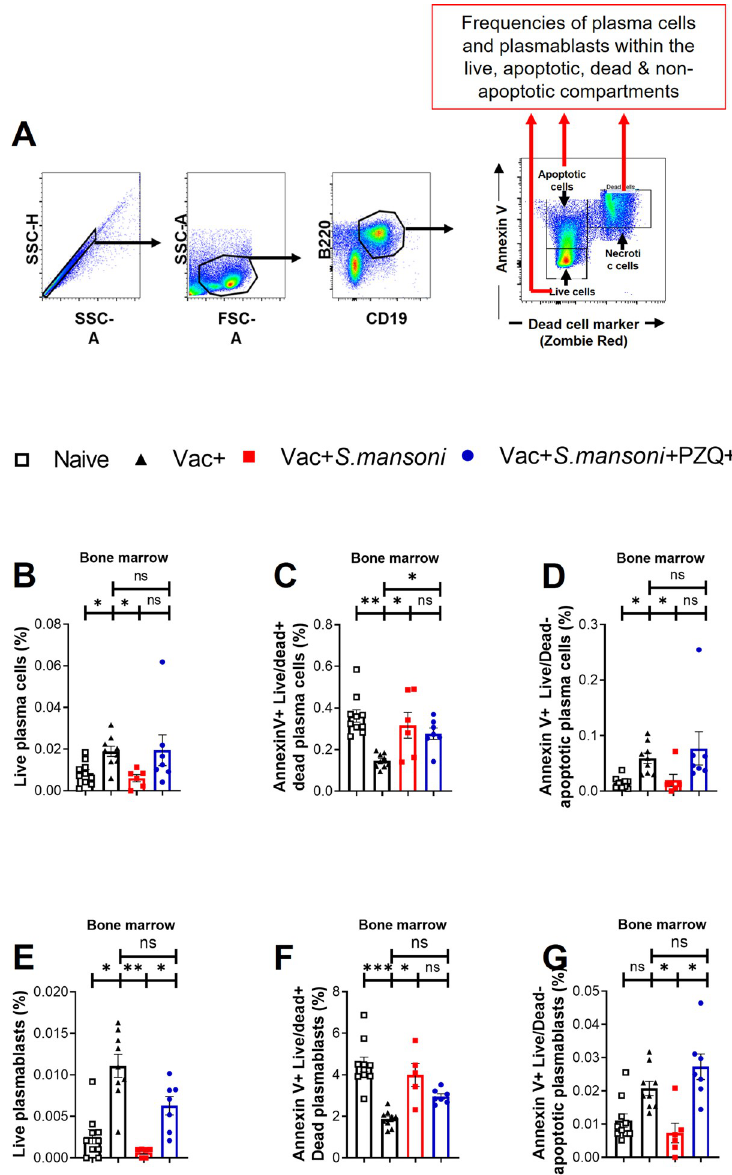
Fig 5. Schistosomiasis-driven death of plasma cells and plasmablasts in the bone marrow is not mediated by apoptosis. (A) Representative gating strategy, illustrative, of apoptotic cells (Annexin V+ Zombie Red-), necrotic cells (Annexin V+ Zombie Red+) and live cells (Annexin V- Zombie Red-) that were each sub-gated for frequencies of plasma blasts or plasma cells at week 18 post-infection. Frequencies of plasma cells (CD138+B220-) within the liver (B.), dead (C.) and apoptotic (D.) IgD-IgG1- B cells of the bone marrows. Frequencies of plasmablasts (CD138+B220+) within the live (E.), dead (F.) and apoptotic (G.) IgD-IgG1- B cells of the bone marrows. Data are expressed as mean ± S.E.M and representative of 2 independent experiments (n = 6–10 mice per group in each experiment); The Vac+ group is used throughout as reference for statistical comparison. Data was analysed by two-way ANOVA followed by FDR corrected multiple comparisons against the Vac+Sm+ group; ns, p > 0.05; � p < 0.05, �� p < 0.001, ��� p < 0.0001; PZQ,